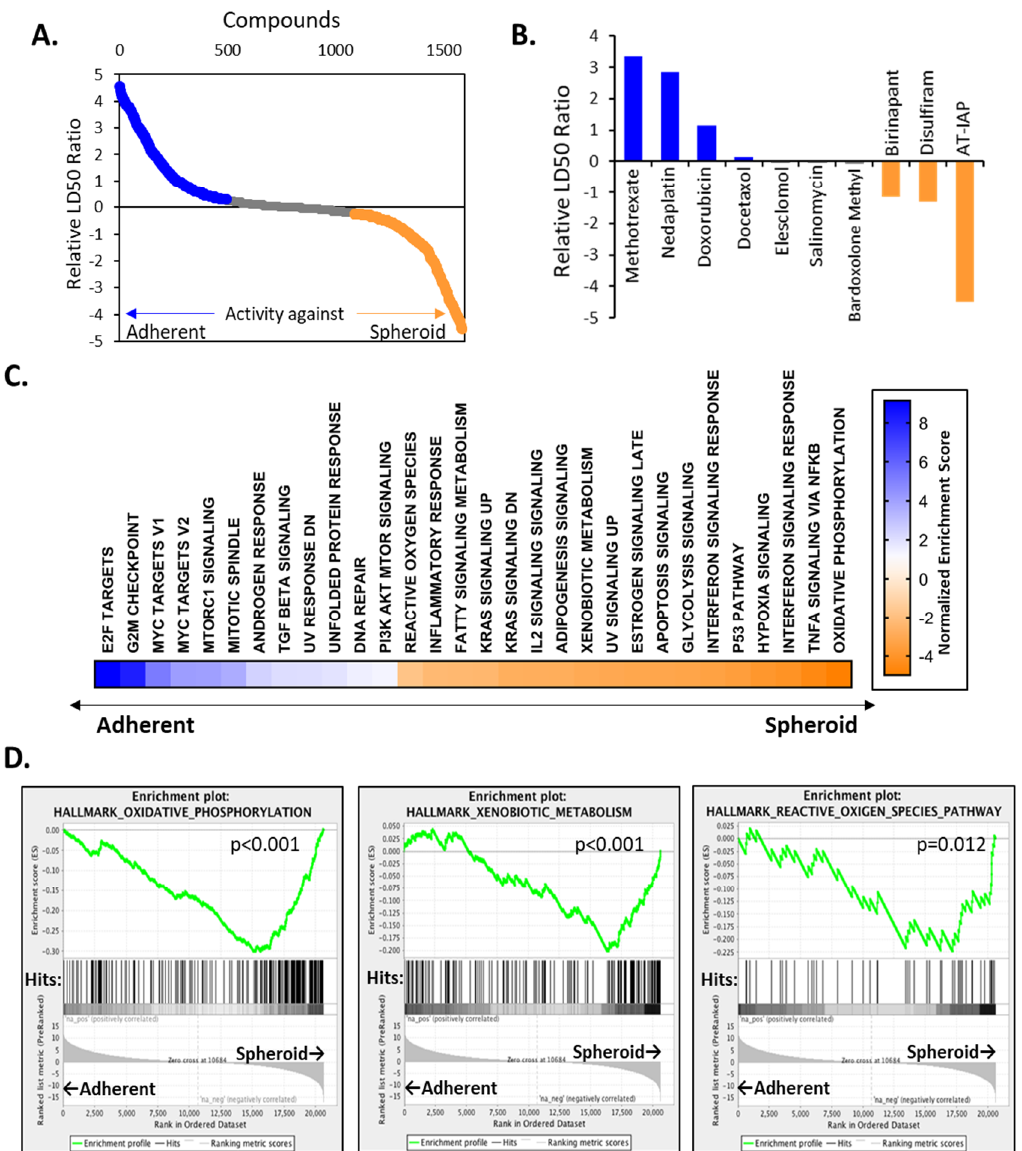
Figure 1. RNAseq reveals enrichment of genes in spheroids are related to oxidative stress management ( A ) Relative ratio of in vitro LD50 values for 1978 drugs in OV90 cells grown in spheroid conditions compared to those grown in adherent conditions. Orange indicates agents that were more effective on spheroids, grey represents agents that were equally effective against spheroids and adherent cells, and blue represents agents more effective against adherently grown cells. ( B ) Selected agents from B relative in vitro LAD50. ( C ) Heatmap of selected GSEA Hallmark pathways enriched in OV90 spheroids from DEG of OV90 spheroids versus OV90 Adherent cells. The color scale of the heatmap represents the ranking of the indicated pathways based on their normalized enrichment score. Orange indicates pathways enriched in spheroids and blue represents pathways enriched in adherently grown cells. ( D ) Enrichment plots of select GSEA pathways enriched in spheroids compared to adherent cells, oxidative phosphorylation, xenobiotic metabolism and reactive oxygen species pathway. The plot represents the correlations of the adherent and spheroid samples with the gene hits in the indicated pathway.